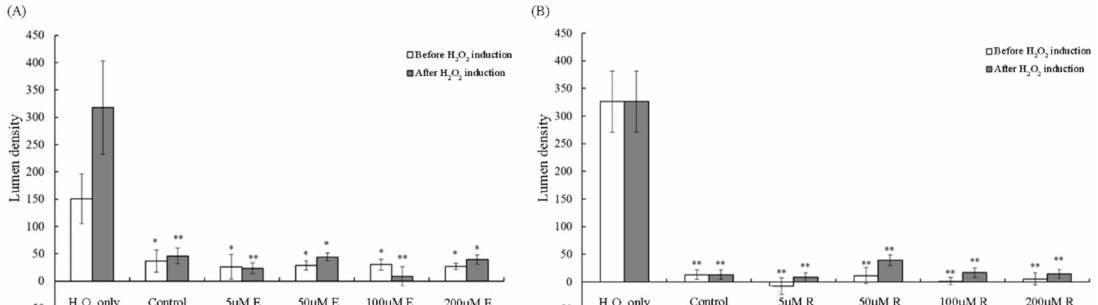
Figure 3. The changes in the level of lumen density when treating OA-like chondrocytes with vitamin E and resveratrol. Adding vitamin E ( A ) or resveratrol ( B ) at 5, 50, 100, and 200 µ M before H 2 O 2 induction (white bars) or after H 2 O 2 induction significantly reduces the level of lumen density. * p < 0.05 and ** p < 0.01 compared with H 2 O 2